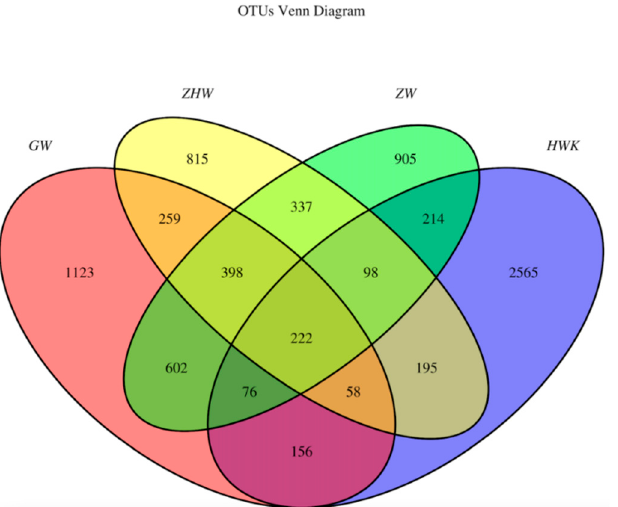
Figure 6. Venn diagrams of the common and unique OTUs of the four groups. Note: HWK repre- sents the control group; GW represents the infection group; ZW represents the treatment group, and ZHW represents the post-treatment group. The numbers in the Venn diagram indicate the common (overlapping part) and unique OTUs of each sample group. The common OTUs represent the overlapping part between two or more groups, and the unique OTUs represent the part where no overlap occurred.